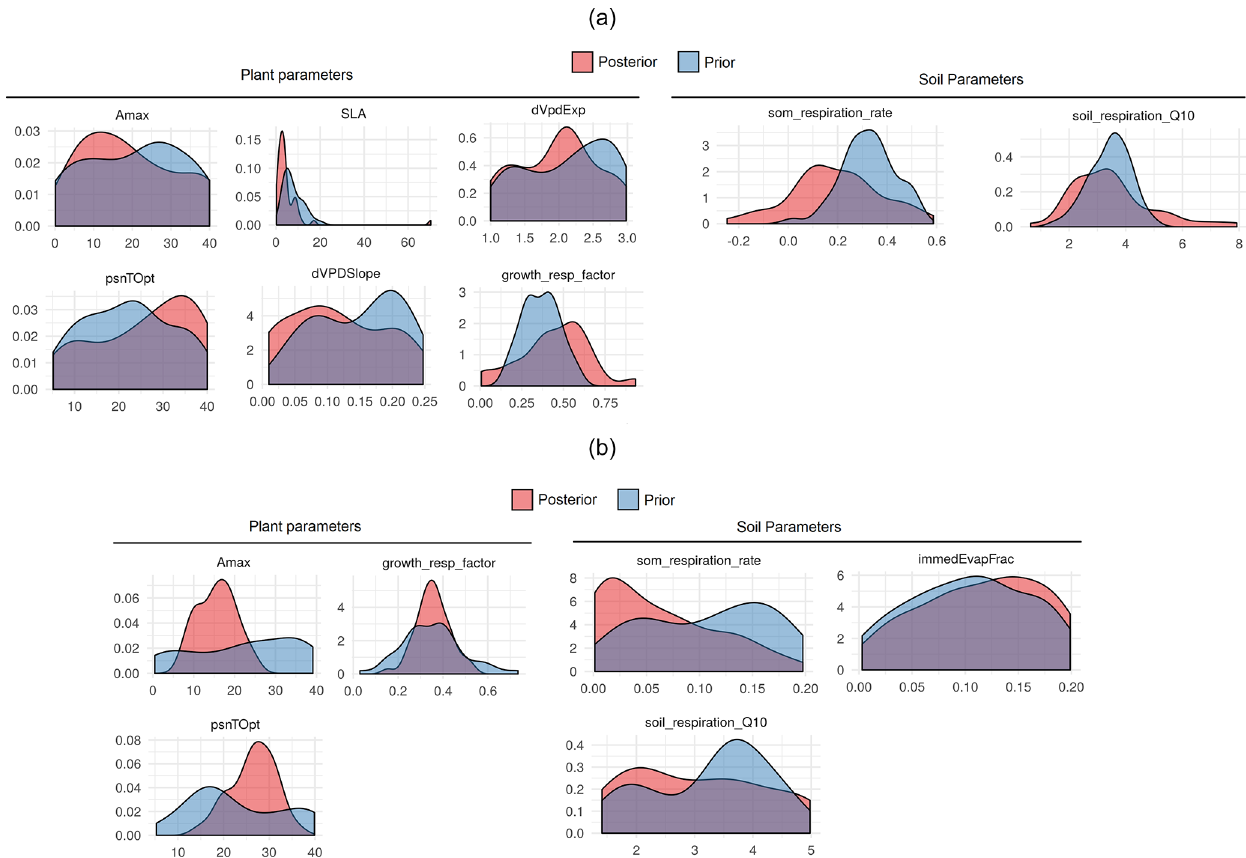
Figure A1. Posterior and prior density of optimized parameters for (a) conifer PFT and (b) grass PFT.